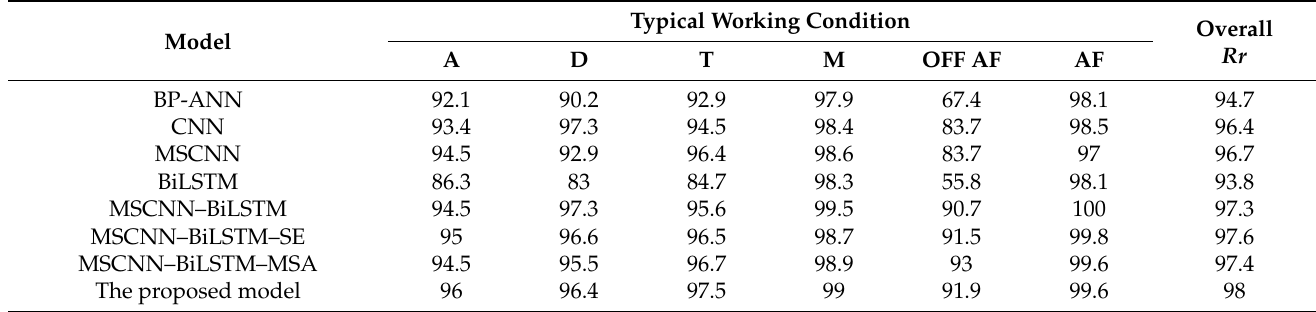
Table 2. Recognition Rp of different models in typical aeroengine working condition